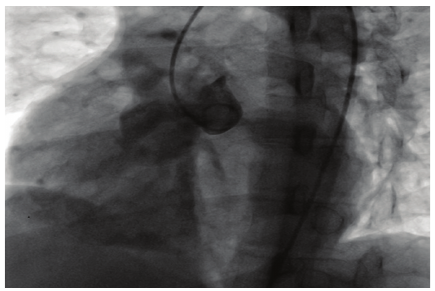
Figure 2: Opacification of right ventricle during angiography of aortic